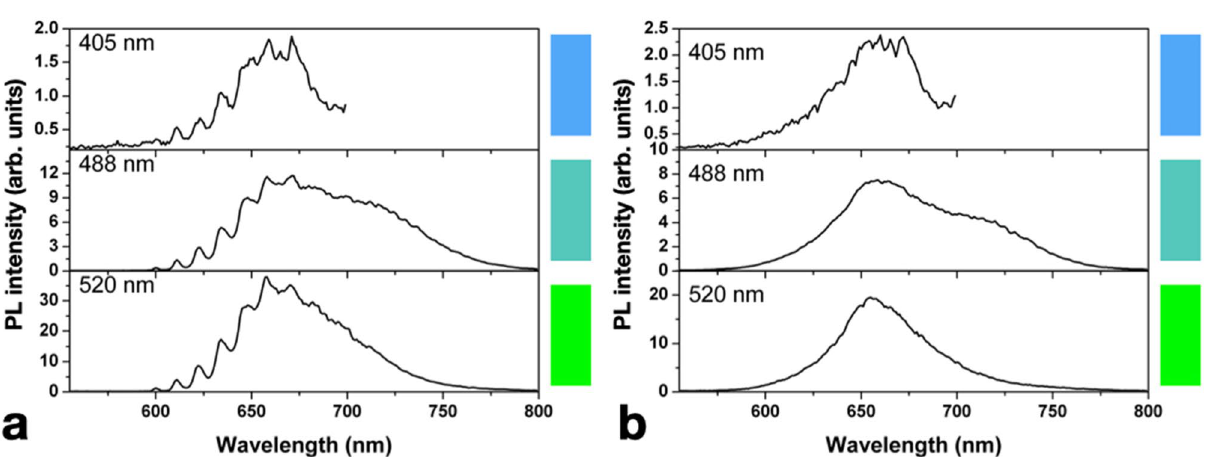
Figure 4. Ensemble PL spectra acquired at 4.5 K ( a ) and room temperature ( b ) from the region of sample #1 implanted at a fluence of 5 × 10 13 cm −2 under different excitation